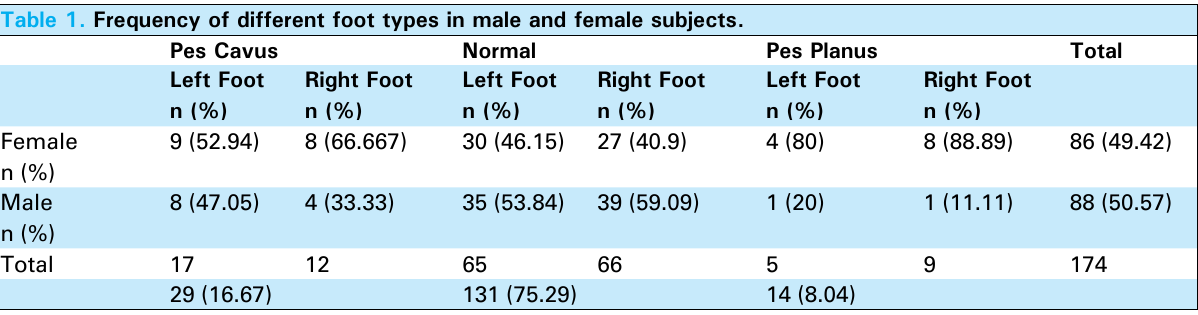
Table 1. Frequency of different foot types in male and female subjects.